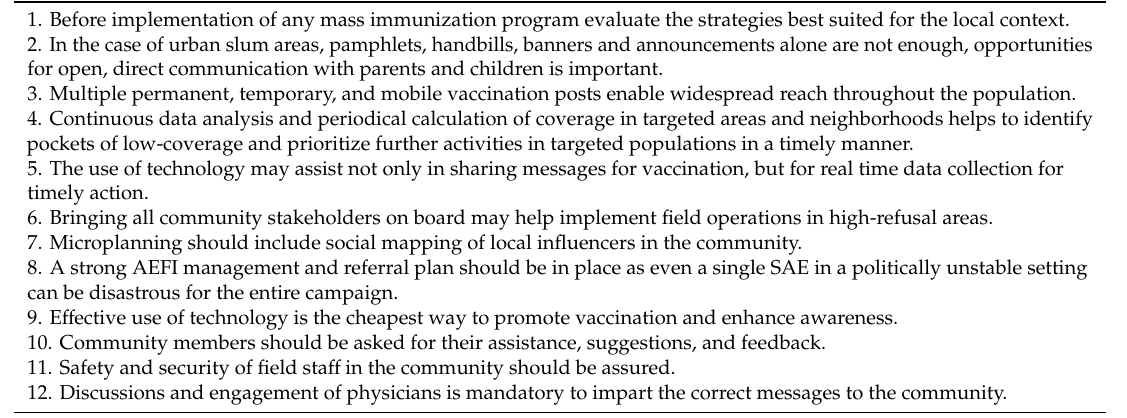
Table 4. List of strategies used and suggested